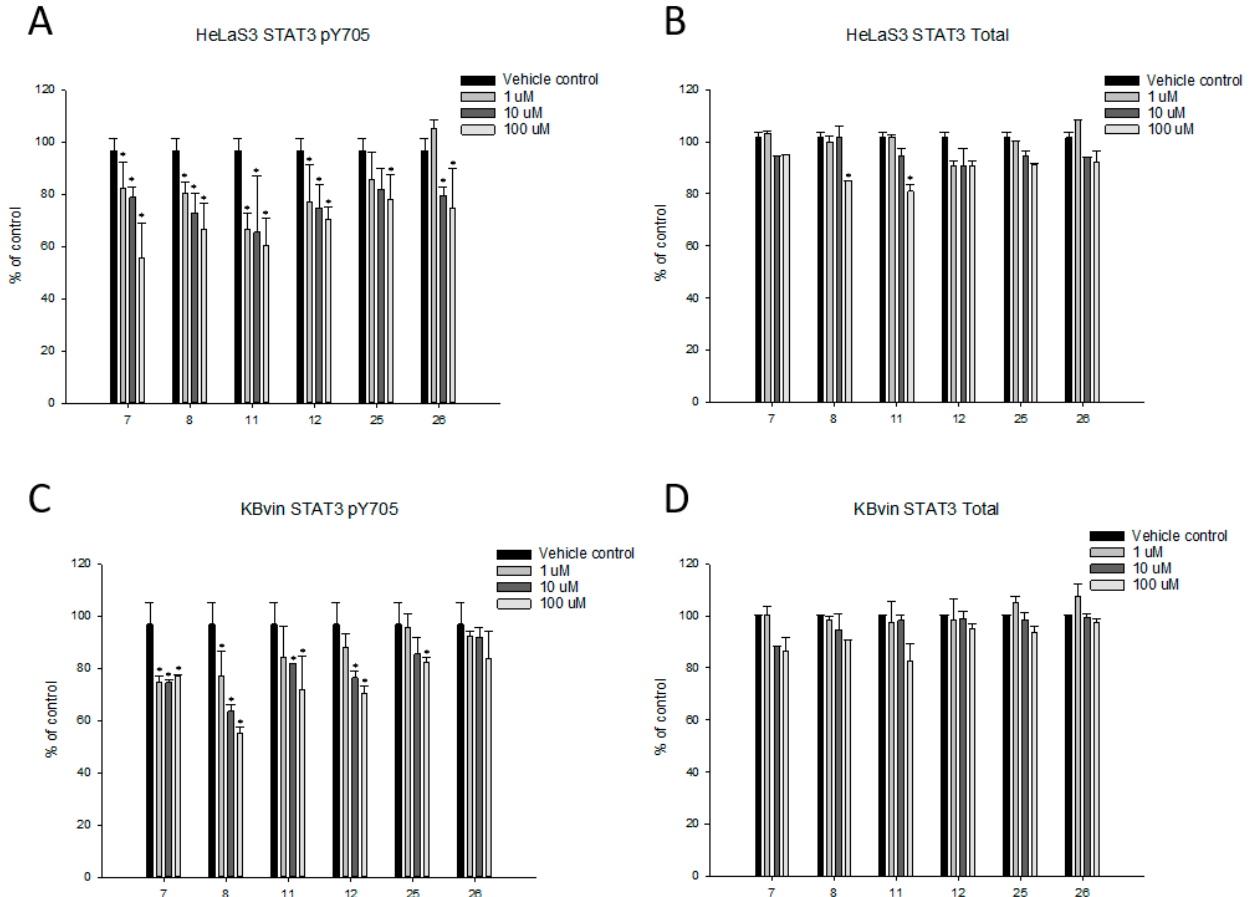
Figure 7. Baseline expression of STAT3 total and STAT3 phosphorylation in HeLaS3 and KBvin. * denotes p < 0.05 as compared to the vehicle control.